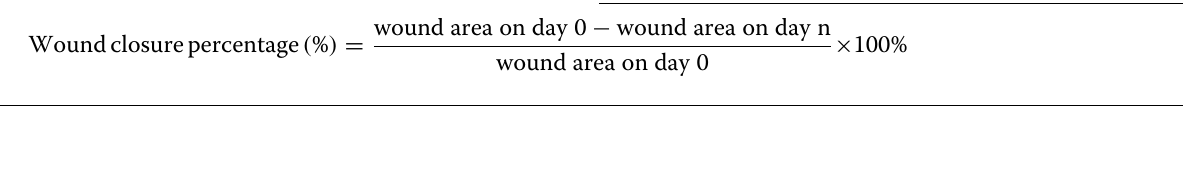
Fig. 1 Persistent high concentration of H 2 significantly accelerated cutaneous wound healing, blood perfusion and vessel formation. A Left: connection between each module in the H 2 chamber system. Middle: Model of the full-thickness cutaneous wound in mouse backs; inside